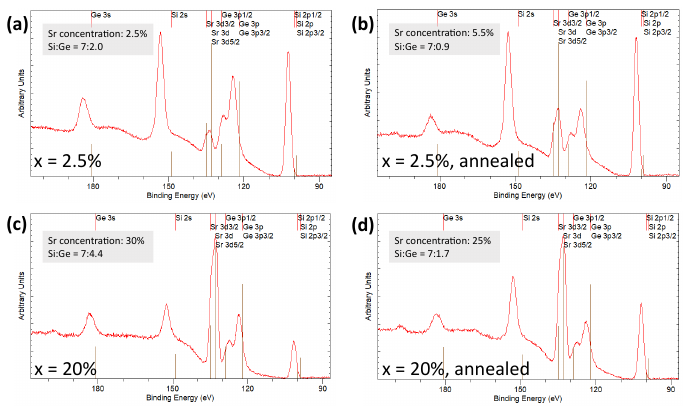
Figure 3. ( a , b ) XPS spectra of x = 2.5% samples before and after annealing. ( c , d ) XPS spectra of x = 20% samples before and after annealing. The grey insets show the concentrations of Sr and the ratios of Si to Ge that were extracted from the spectra. We estimate the error in the individual elemental amounts to be ±